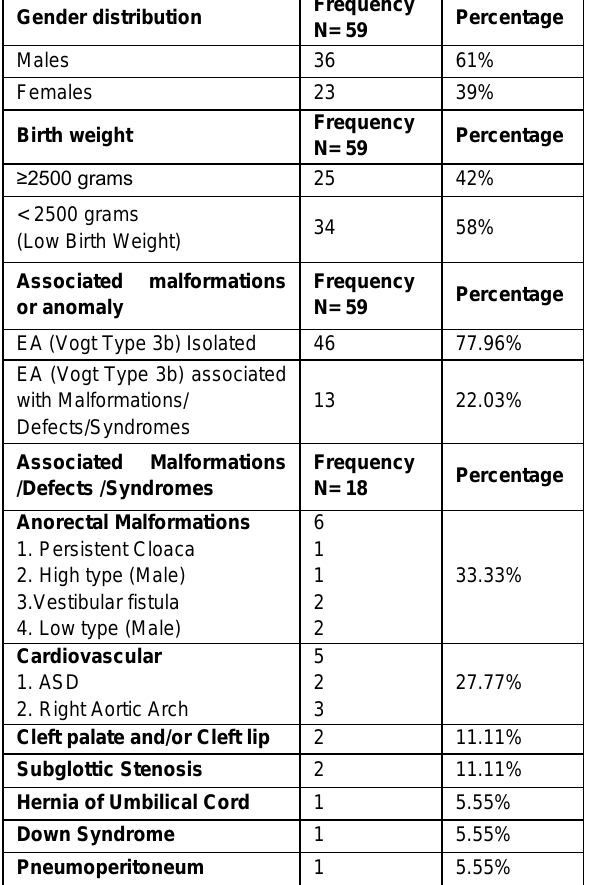
Table1: Demographic characteristics of patients in the study Gender distribution